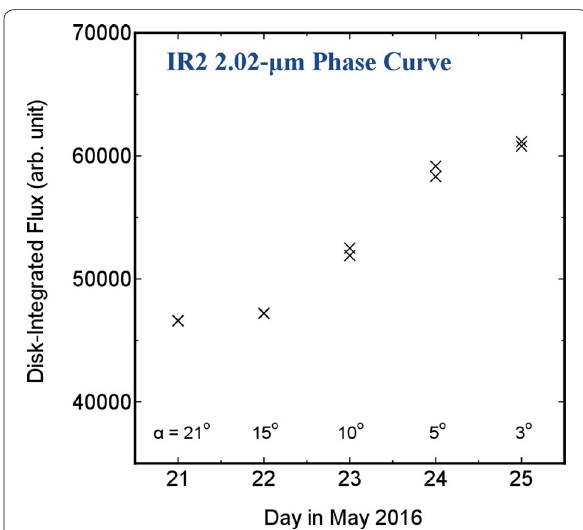
Fig. 13 Disk‑integrated 2.02‑μm fluxes plotted as a function of time. Two images, separated by 4 h, are acquired each day. The two measurements are extremely consistent with each other such that they are indistinguishable for May 21 and 22. The day‑to‑day variation originates from the solar phase dependence (so‑called phase curve) and spatial/temporal variation of cloud‑top